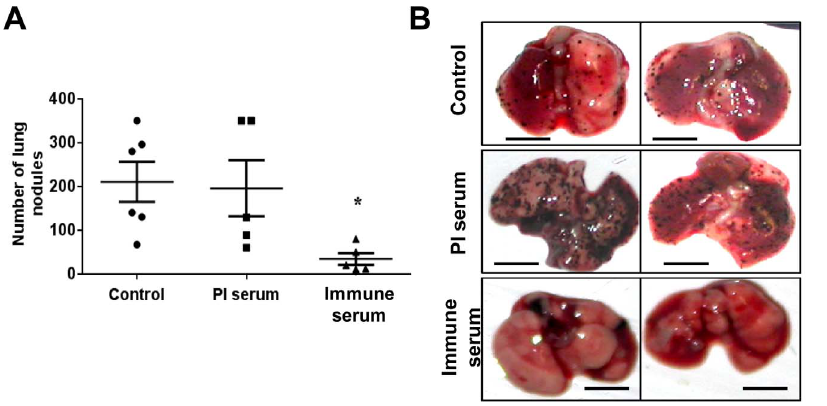
Figure 6. Passive transfer of rabbit anti-arazyme polyclonal antibodies inhibited murine melanoma metastasis. ( A ) C57Bl/6 mice were i.v. injected with 3 6 10 5 B16F10-Nex2 melanoma cells. Starting on the 1 st day after tumor cell inoculation, 5 doses of 300 m L of rabbit pre-immune ( PI serum ) or the same volume of rabbit arazyme-specific immune serum was administered i.p. every other day. Melanotic pulmonary nodules were counted using an inverted microscope thirteen days after tumor cell inoculation. Untreated control group, n=7 and pre-immune/immune serum treated groups, n=5.*, p # 0.05. ( B ) Representative images of lungs from animals treated as described in (A). Scale bar, 5 mm.